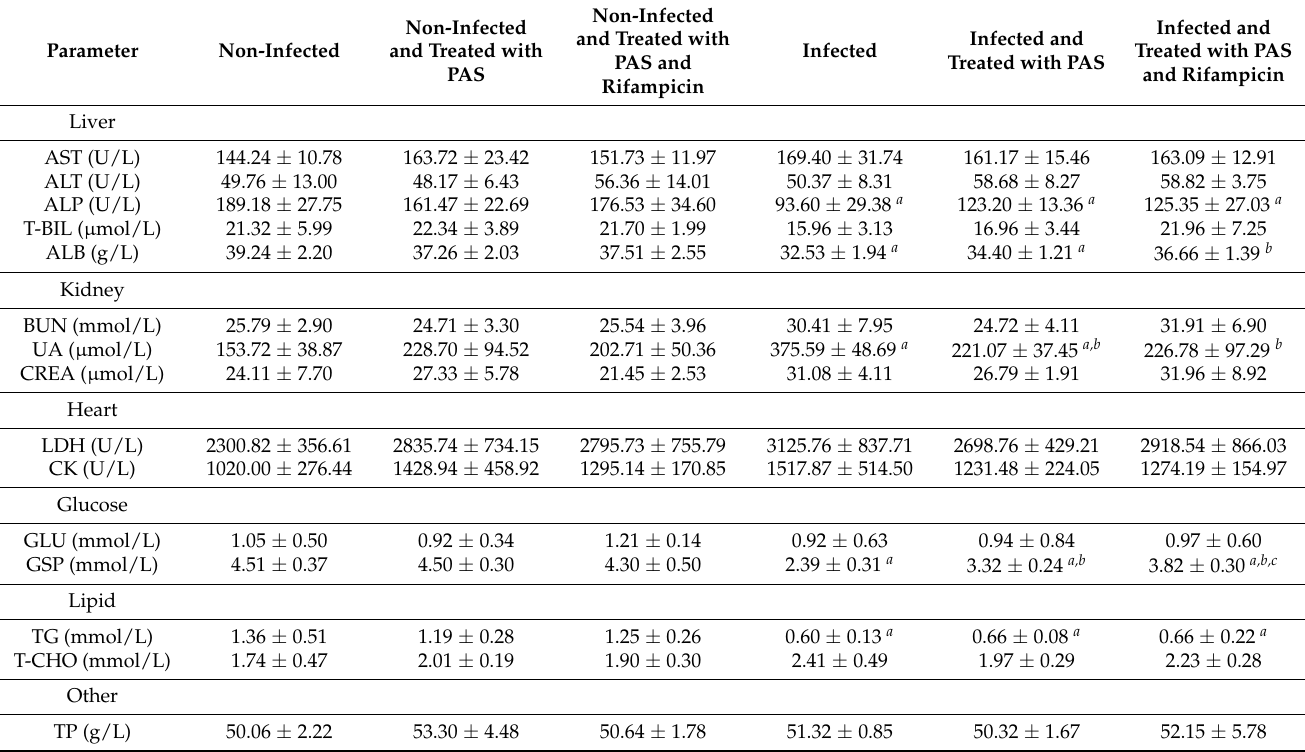
Table 2. Effects of PAS treatment on serum biochemical parameters in